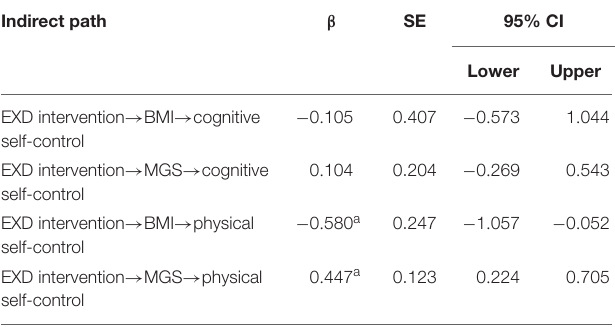
TABLE 5 | Bootstrapping indirect effect and 95% CI for the mediation